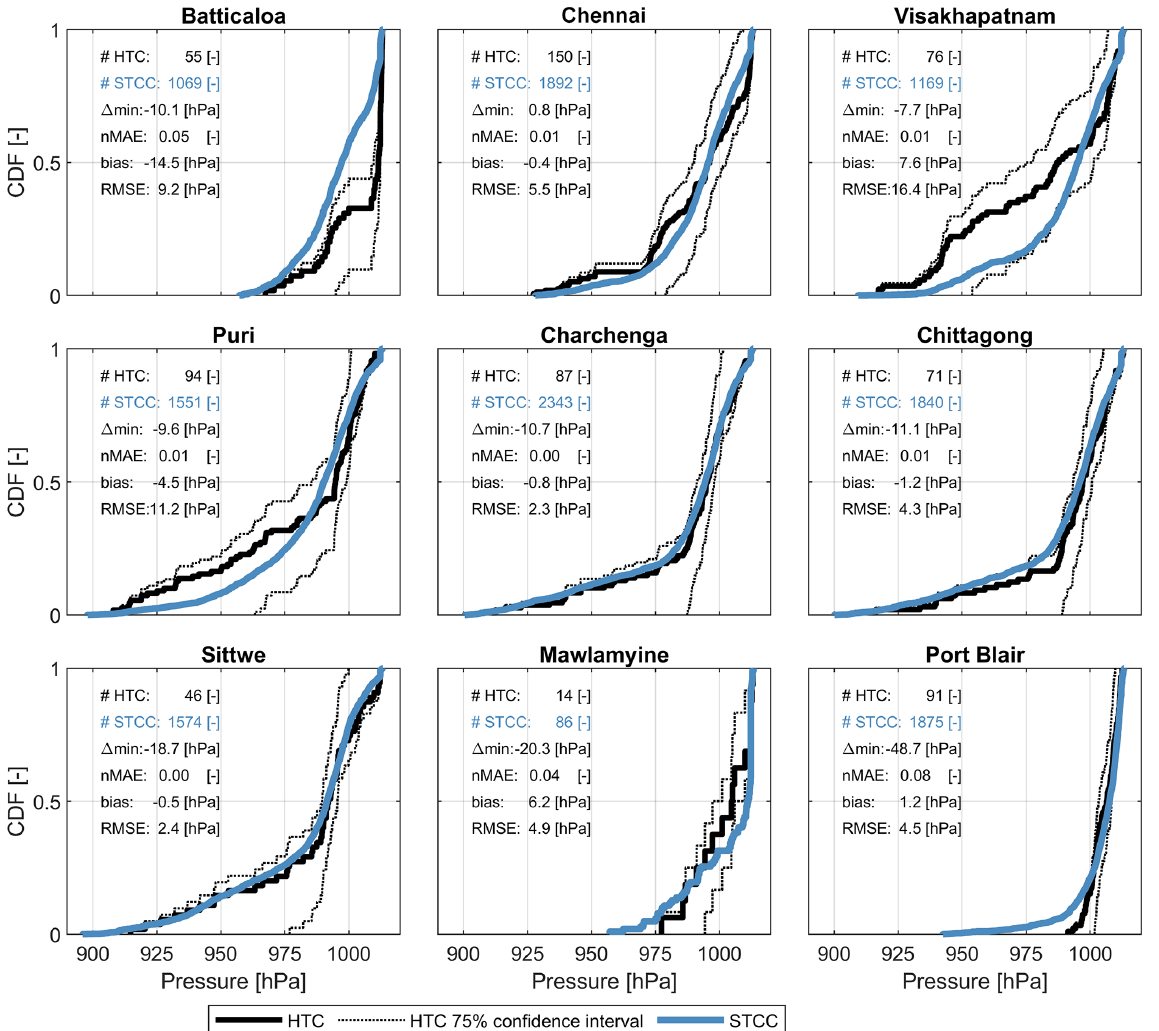
Figure B4. Comparison between CDFs of central pressure for HTCs (black line) with 75% confidence intervals (dashed line) and STCC (blue line) at nine locations along the Bay of Bengal. The functions are estimated based on TCs within a 200km radius of each location. The number of samples (time steps of a TC) within the 200km radius is indicated (#HTC and #STCC), alongside several statistical parameters comparing the HTC and STCC distributions (i.e., absolute difference in minima ( (cid:49) min), normalized mean absolute error (nMAE), the relative bias of the median value (bias) and the root-mean-square error (RMSE) of the whole CDF. The nine locations are shown in Fig. 1.